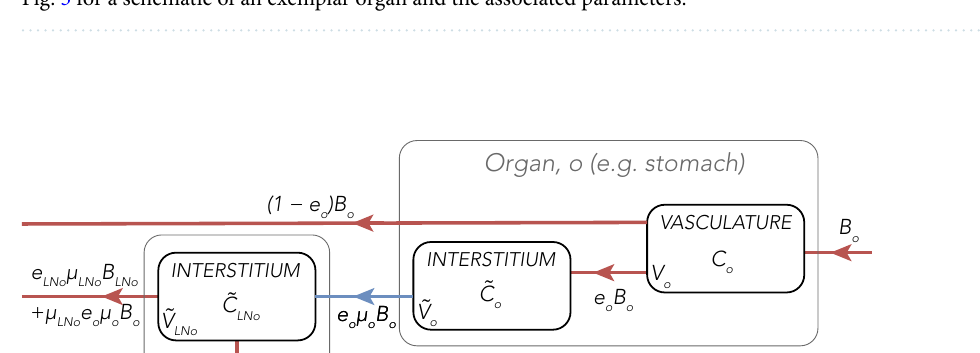
Table 1. Definitions and units of parameters and variables in the model described in “Model overview” section. Different suffixes, such as LA&LV (left atrium, left ventricle, and large arteries), RA&RV (right atrium, right ventricle, and large veins), PC (pulmonary circuit), med (mediastinal lymph nodes) are also used. See Fig. 3 for a schematic of an exemplar organ and the associated parameters.